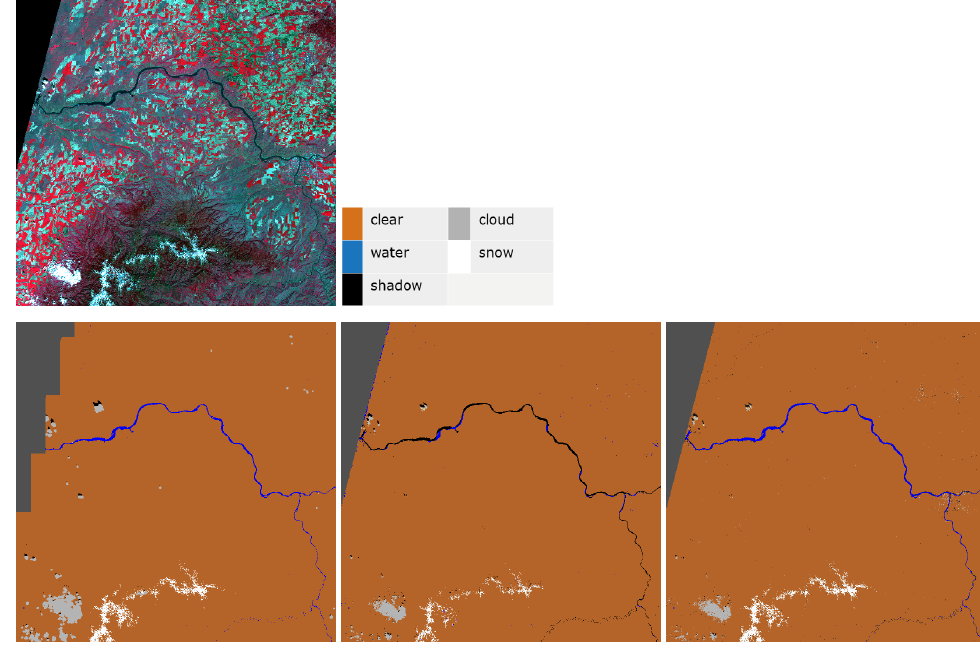
Figure 9. Top row: CIR (RGB = 865,665,560 nm) composite of scene ID 20 (USA Rimrock). Bottom row (left to right): Fmask, ATCOR and Sen2Cor classification